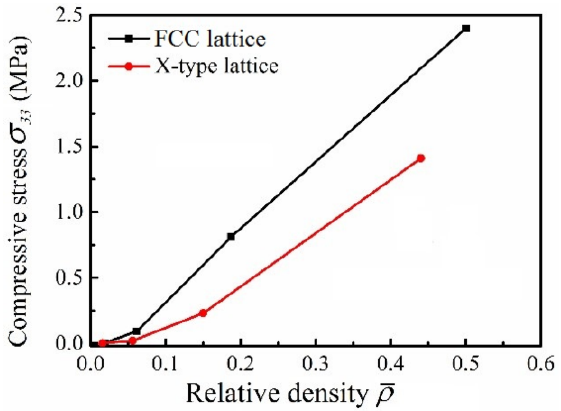
Figure 7. The variation in peak stress of structure with relative density.